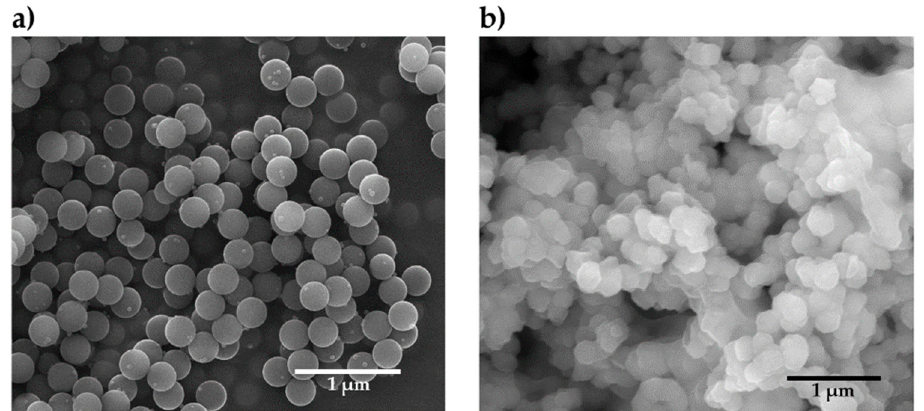
Figure 4. Scanning electron microscopy (SEM) micrographs of ( a ) functionalized silica NPs and ( b ) CSNPs.